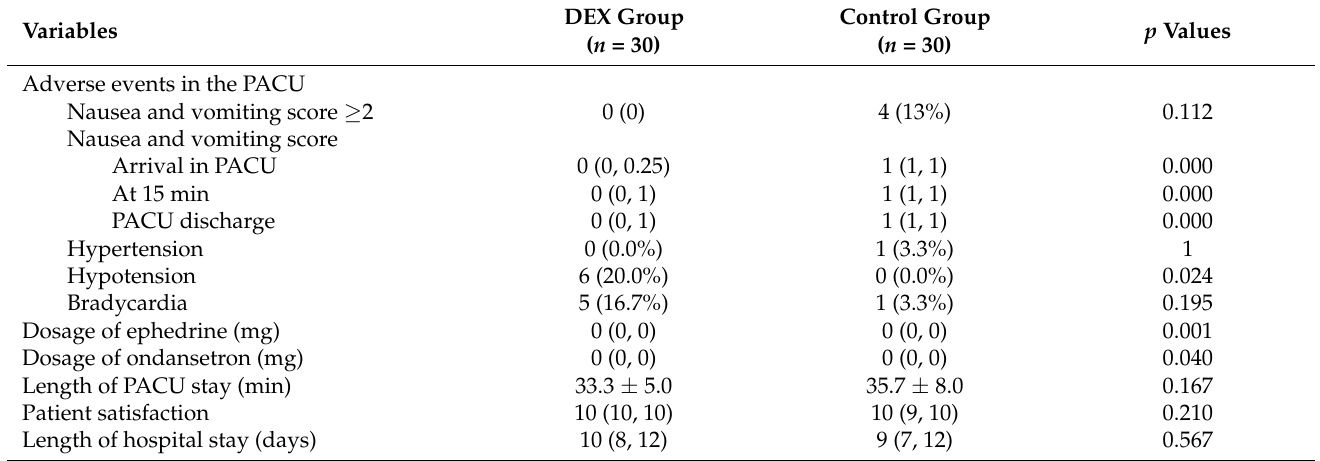
Table 4. Postoperative